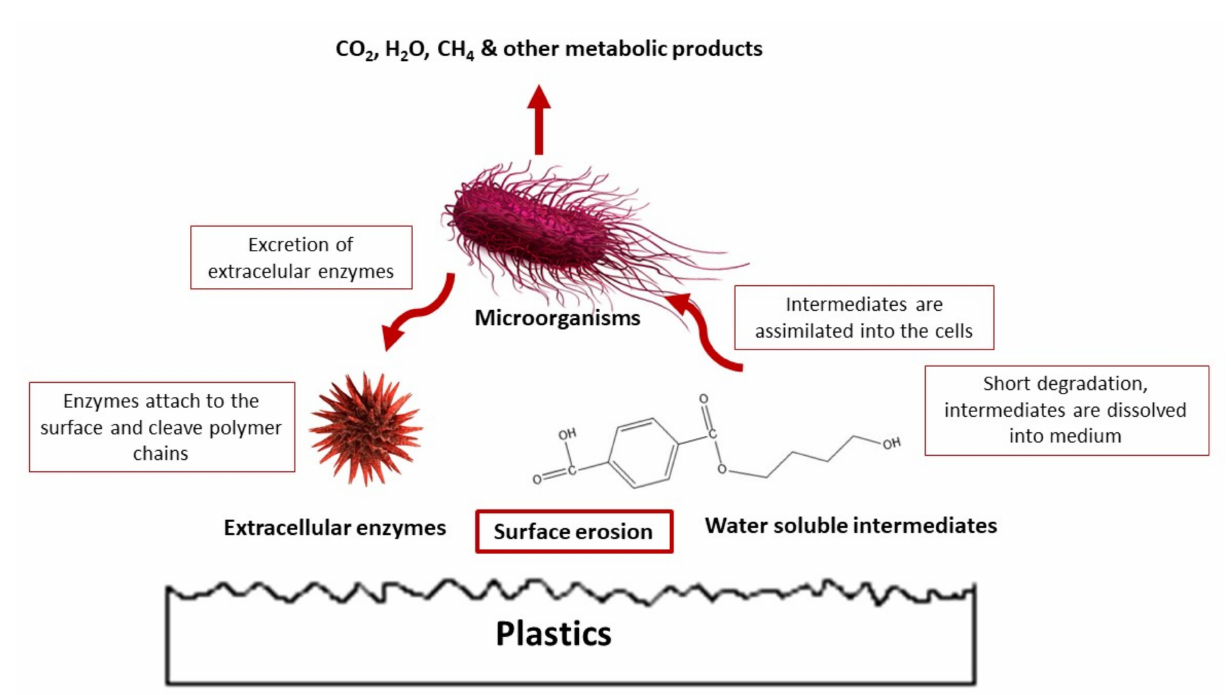
Figure 12. Mechanism of enzymatic biodegradation of plastics under aerobic conditions, adapted from